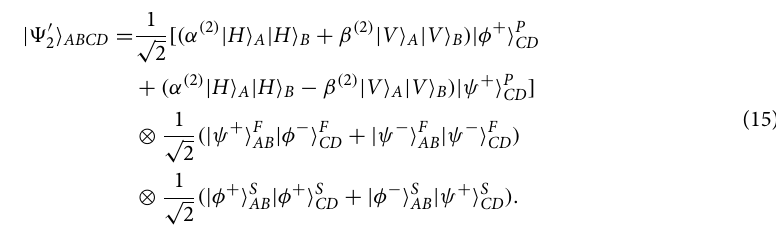
Alice and Bob perform Hadamard operations on the three DOFs of photons C and D, respectively, and then the (cid:31) 2 can be transformed into the state state | � ABCD